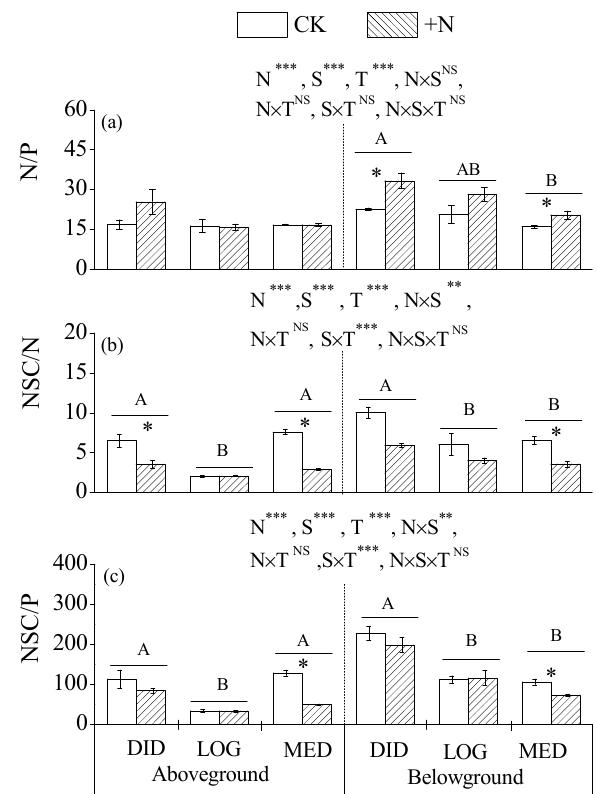
Figure 3. N/P ( a ), NSC/N ( b ), NSC/P ( c ) in aboveground and belowground tissues of the three understory plants in the Chinese fir forest plantation treated by nitrogen addition (+N) or in the control (CK). Note: Values shown are the means ± SE ( n = 4). The asterisks (*) indicate significant differences at the p < 0.05 level between the control and N-treatment plots within a single species. Different capital letters indicate significant differences ( p < 0.05) among the three species within the same tissue based on Duncan’s multiple range test. N = nitrogen, P = phosphorus, NSC = nonstructural carbohydrates; N = nitrogen addition, S = species, T = tissues. NS , not significant; * p < 0.05; ** p < 0.01; *** p < 0.001. DID: D. dichotoma , LOG: L. gracile , MED: M. dodecandrum.